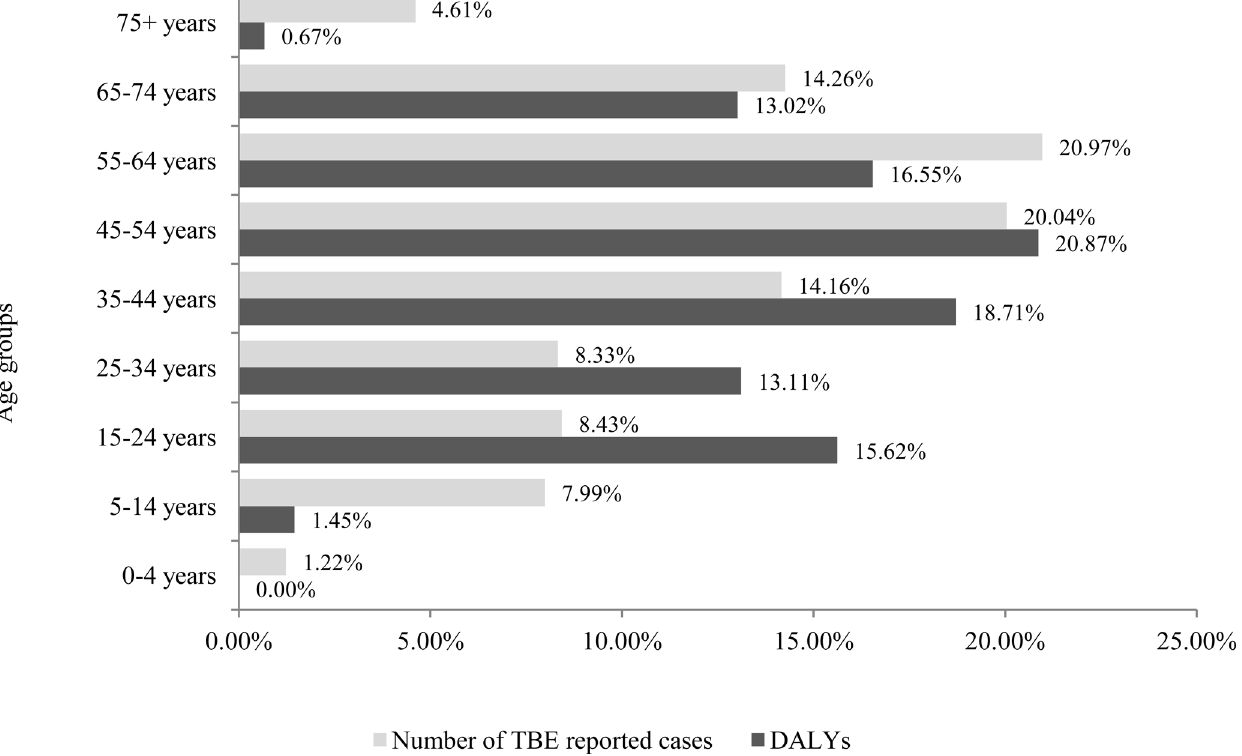
Fig 2. Comparison of relative TBE burden expressed in total DALYs from the population perspective with the relative TBE burden expressed by the number of reported cases by age groups. DALYs and reported cases are averages over 2004 – 2011.